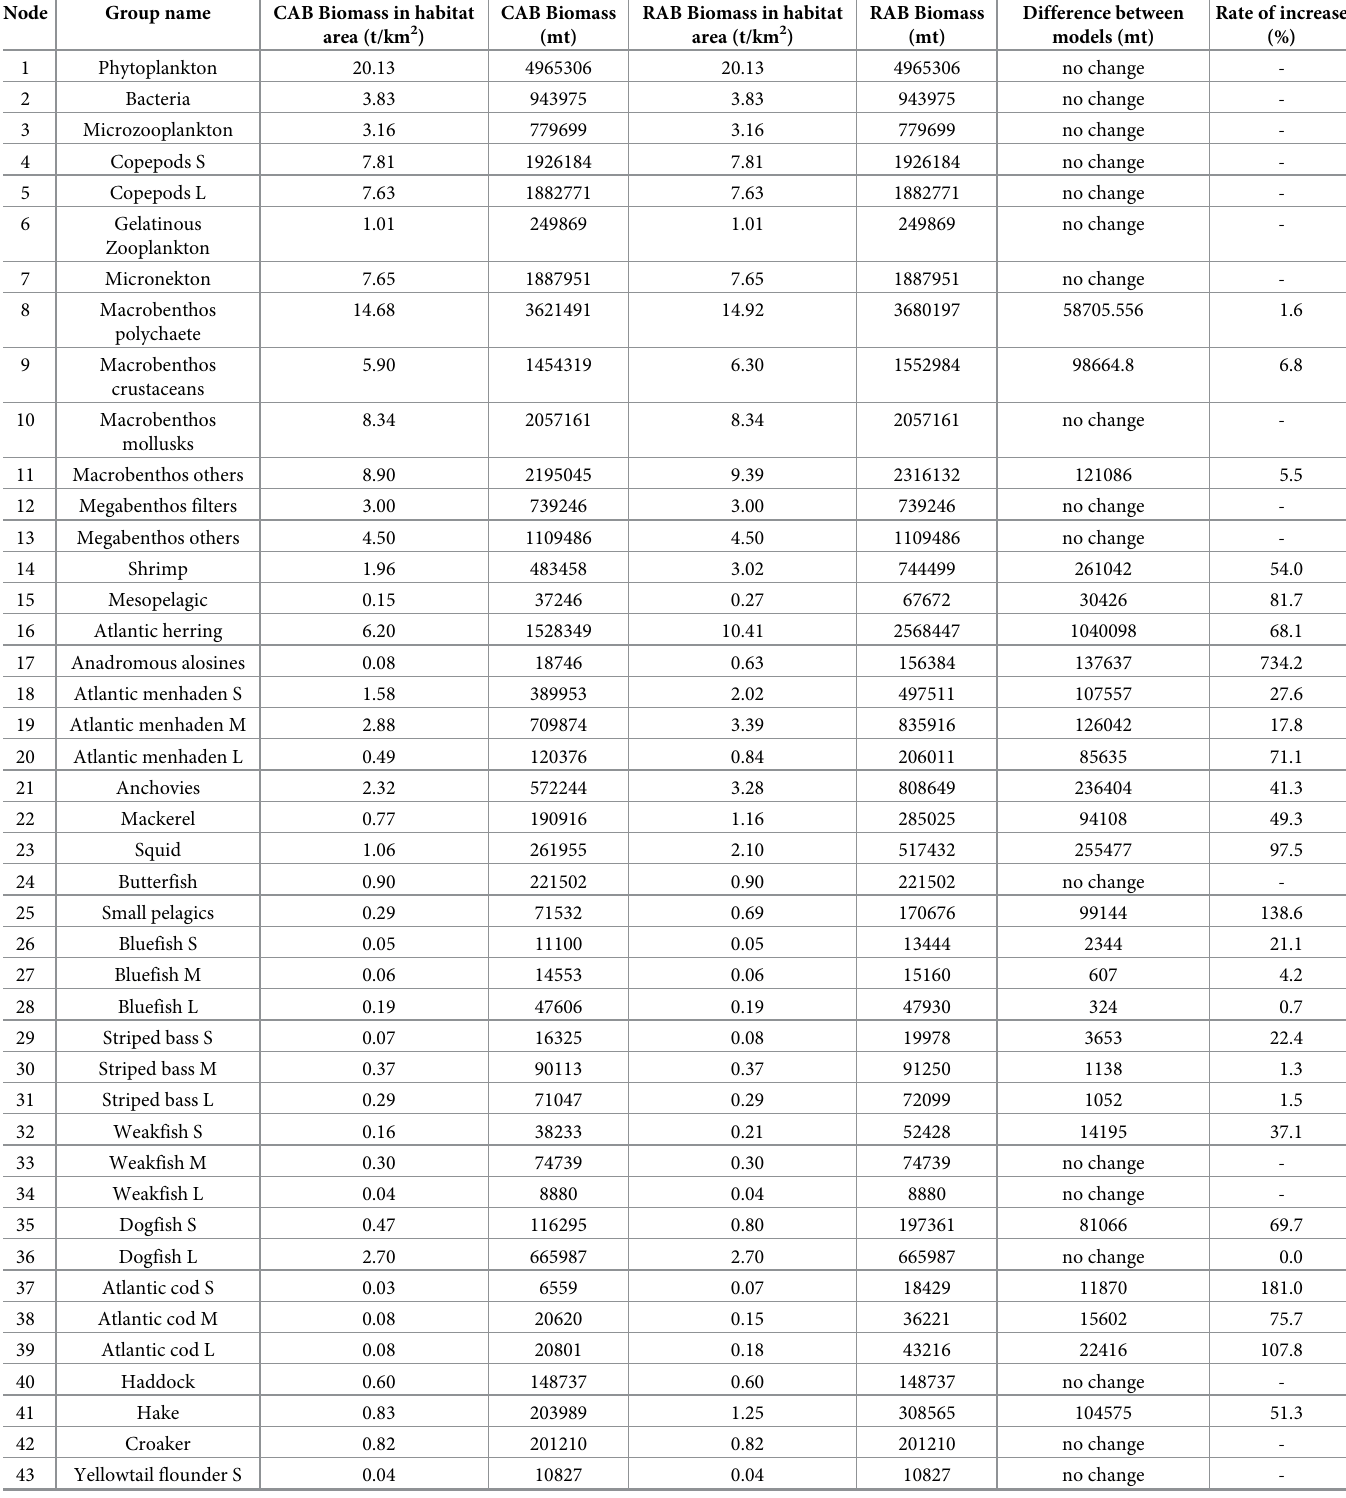
Table 3. Differences in biomass between the CAB and RAB